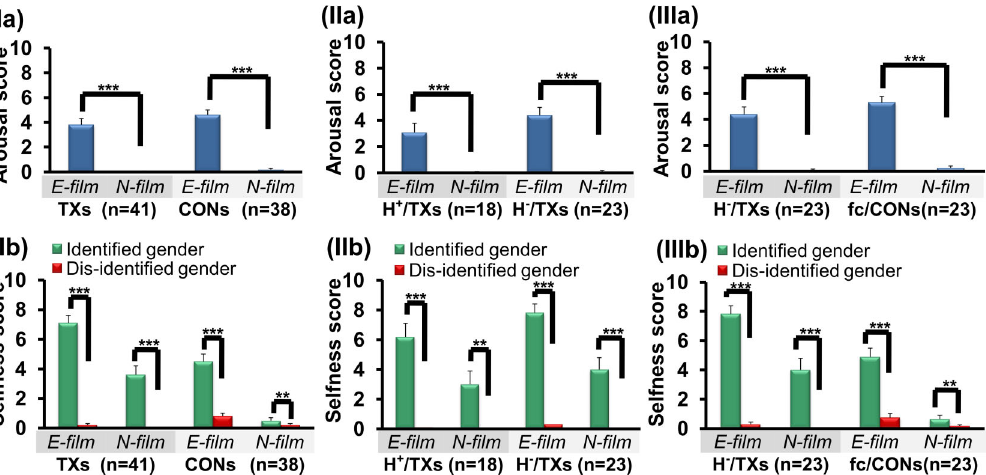
Figure 1. Behavioral and neuroimaging data. Panel Ia. Arousal score . Both TXs and CONs were highly aroused when watching the E-films. Panel Ib. Selfness score . Both TXs and CONs demonstrated high selfness ratings for their desired genders as opposed to the un-desired genders while watching the E-films. TXs, compared to CONs, rated higher selfness scores (P , 0.001) for their desired genders when watching the E-films. Notably, TXs also reported high selfness ratings even while watching the N-films. In contrast, the CONs did not show such significant differences compared to the TXs and featured much lower selfness scores for their desireed genders when watching the N-films (P , 0.001). Panel IIa. Arousal score . Both hormone-treated (H + /TXs) and untreated (H 2 /TXs) subgroups rated significantly higher levels of arousal when watching the E-films vs. N-films. Panel IIb. Selfness score . Both hormone-treated (H + /TXs) and untreated (H 2 /TXs) subgroups rated significantly higher selfness scores for the desired gender compared to the un-desired gender when watching the E-films and N-films. Panel IIIa and Panel IIIb . The imaging subgroups (H 2 /TXs and fc/CONs) showed similar rating patterns as those of their original groups (TXs and CONs, respectively). The two-tailed Wilcoxon signed-rank test was used for within-group comparisons. The asterisks indicate the level of significance. ** P , 0.01, *** P ,